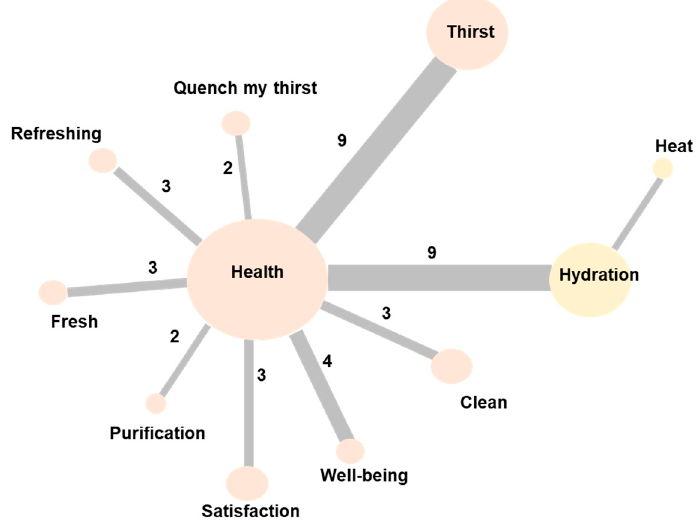
Figure 2. Graphic representation of the similarities of the words related to the social representation of “drinking water”, in parents of schoolchildren from Zapopan, Mexico ( n = 23). The words presented in the figure are those mentioned concurrently among the participants. The size of the sphere is proportional to the number of times the word was mentioned (the larger the number, the greater the co-occurrence). The number makes reference to the number of times the term was mentioned, while the colors represent groups of semantic proximity. Table 2. Prototypic analysis of the social representation of “drinking water” in parents of children from elementary schools in Zapopan, Mexico ( n =